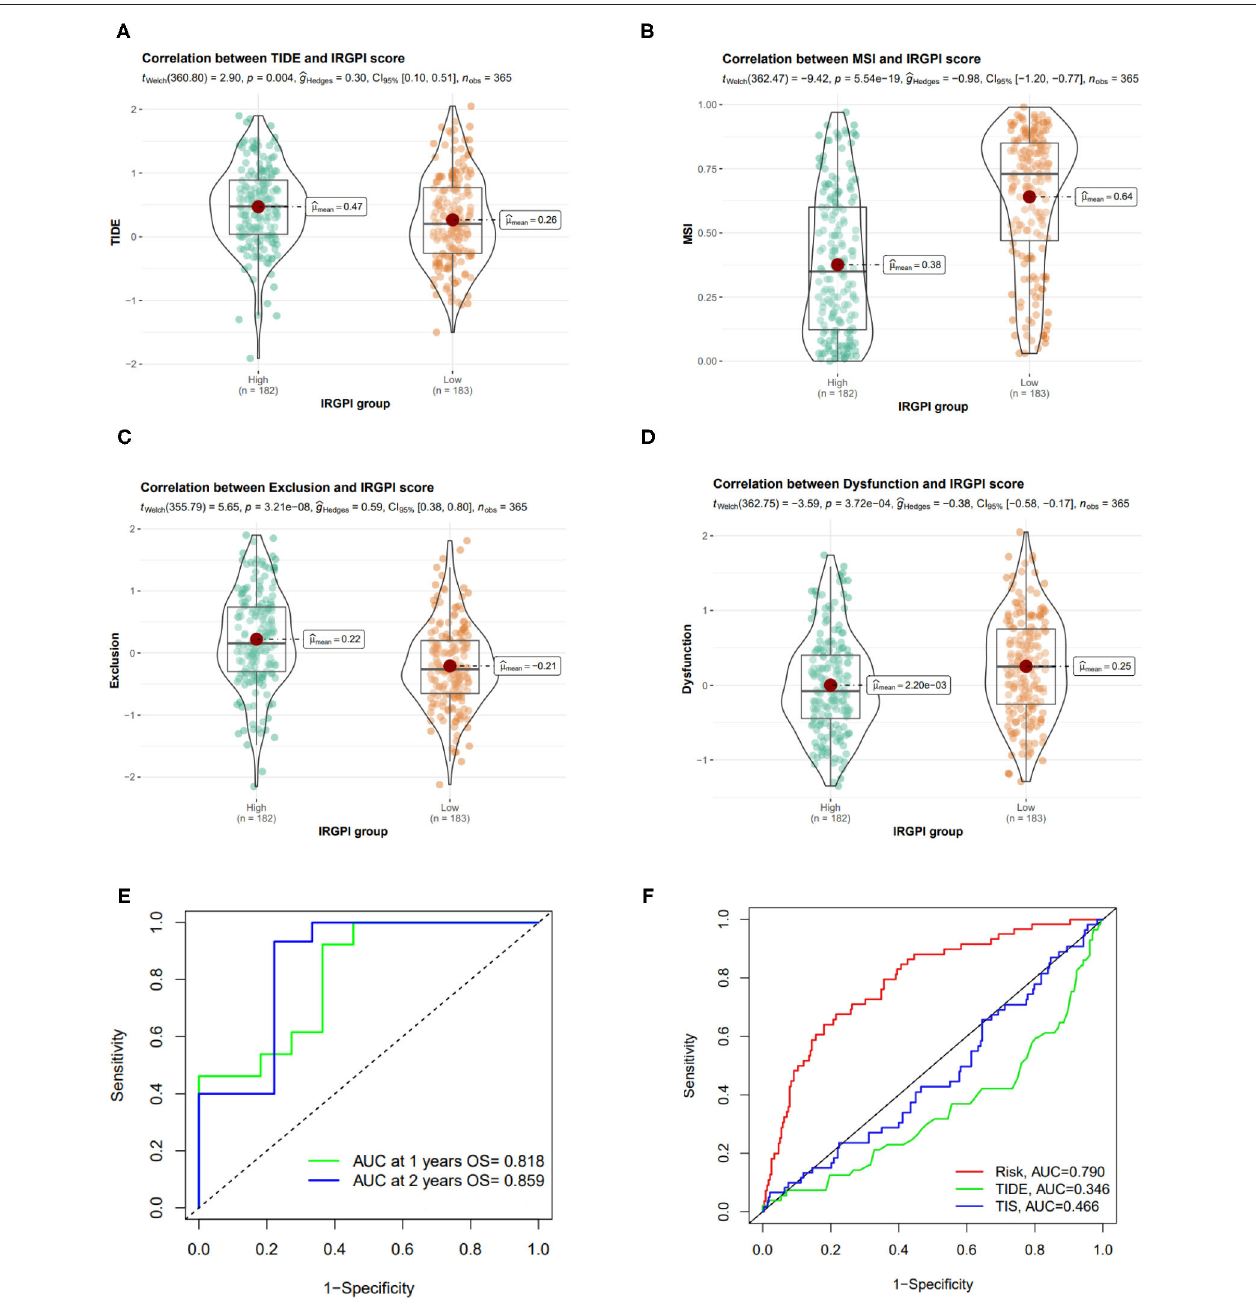
FIGURE 8 | Correlation of IRGPI risk score and other immune-related prognostic scores. (A–D) TIDE, MSI, T cell exclusion, and T cell dysfunction score in different IRGPI groups. (E) ROC curve and AUC values of IRGPI risk score in predicting the 1- and 2-year OS on GSE140901 cohort who received anti-PD-L1 therapy. (F) Performance comparison between of IRGPI risk, TIDE and TIS in predicting 1-year OS on GSE140901 cohort.